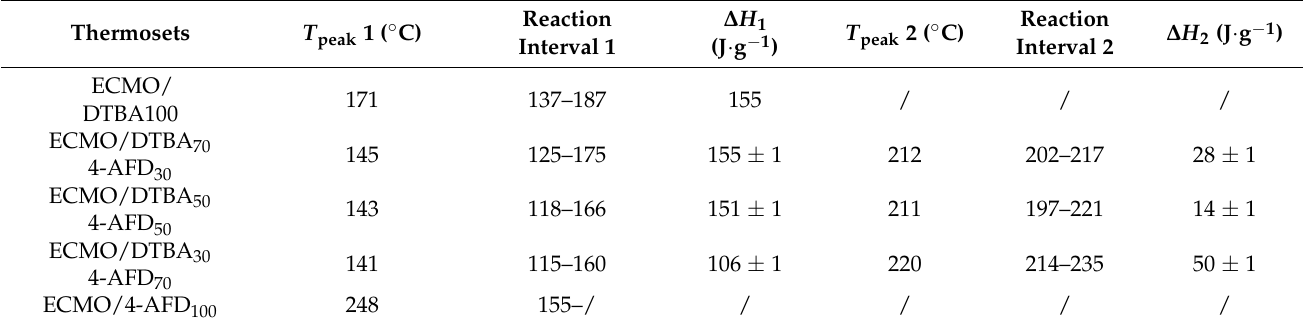
Table 1. DSC results for the curing of ECMO/DTBA x 4-AFD y systems.